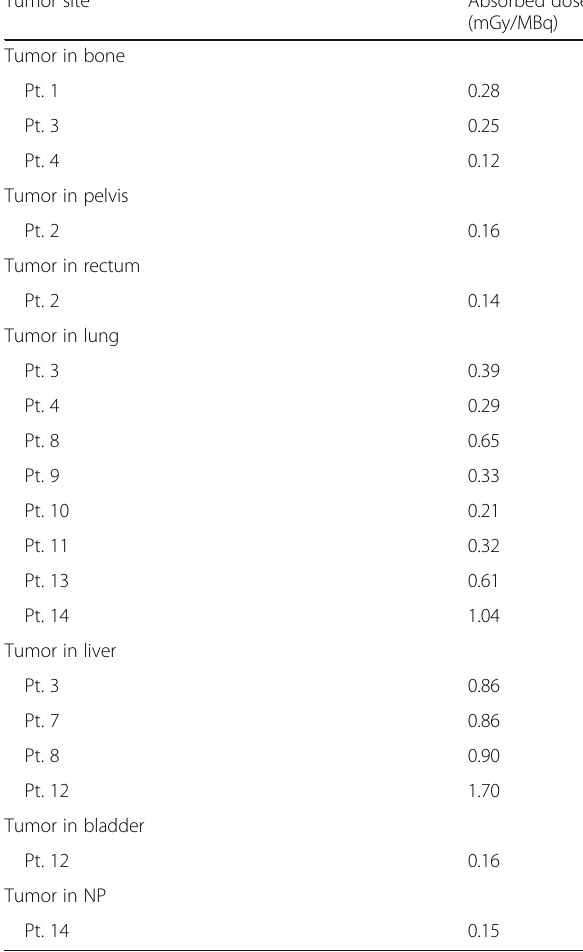
Table 5 Highest absorbed doses (mGy/MBq) of 188 Re-liposome in tumor lesions of patients ( n = 12) Tumor